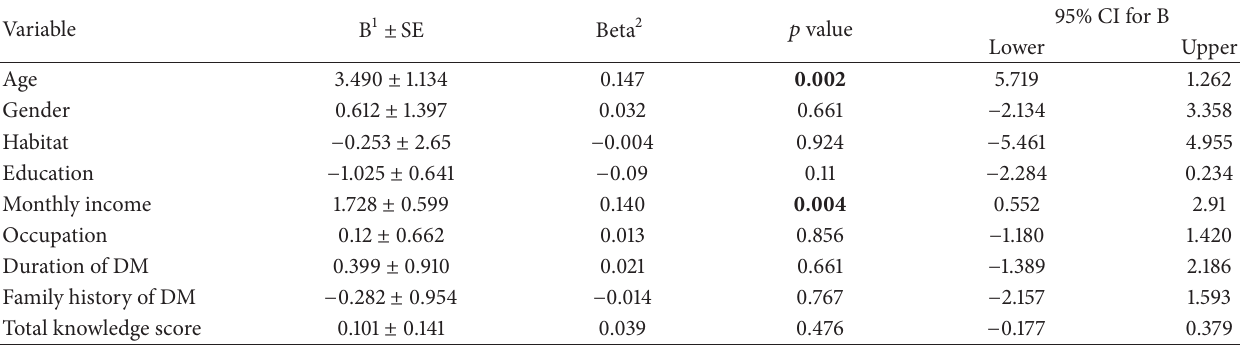
diabetes mellitus. Table 6: Multivariable regression analysis of waist circumference as a dependent variable with other parameters among patients with type 2 DM ( 𝑛 = 500